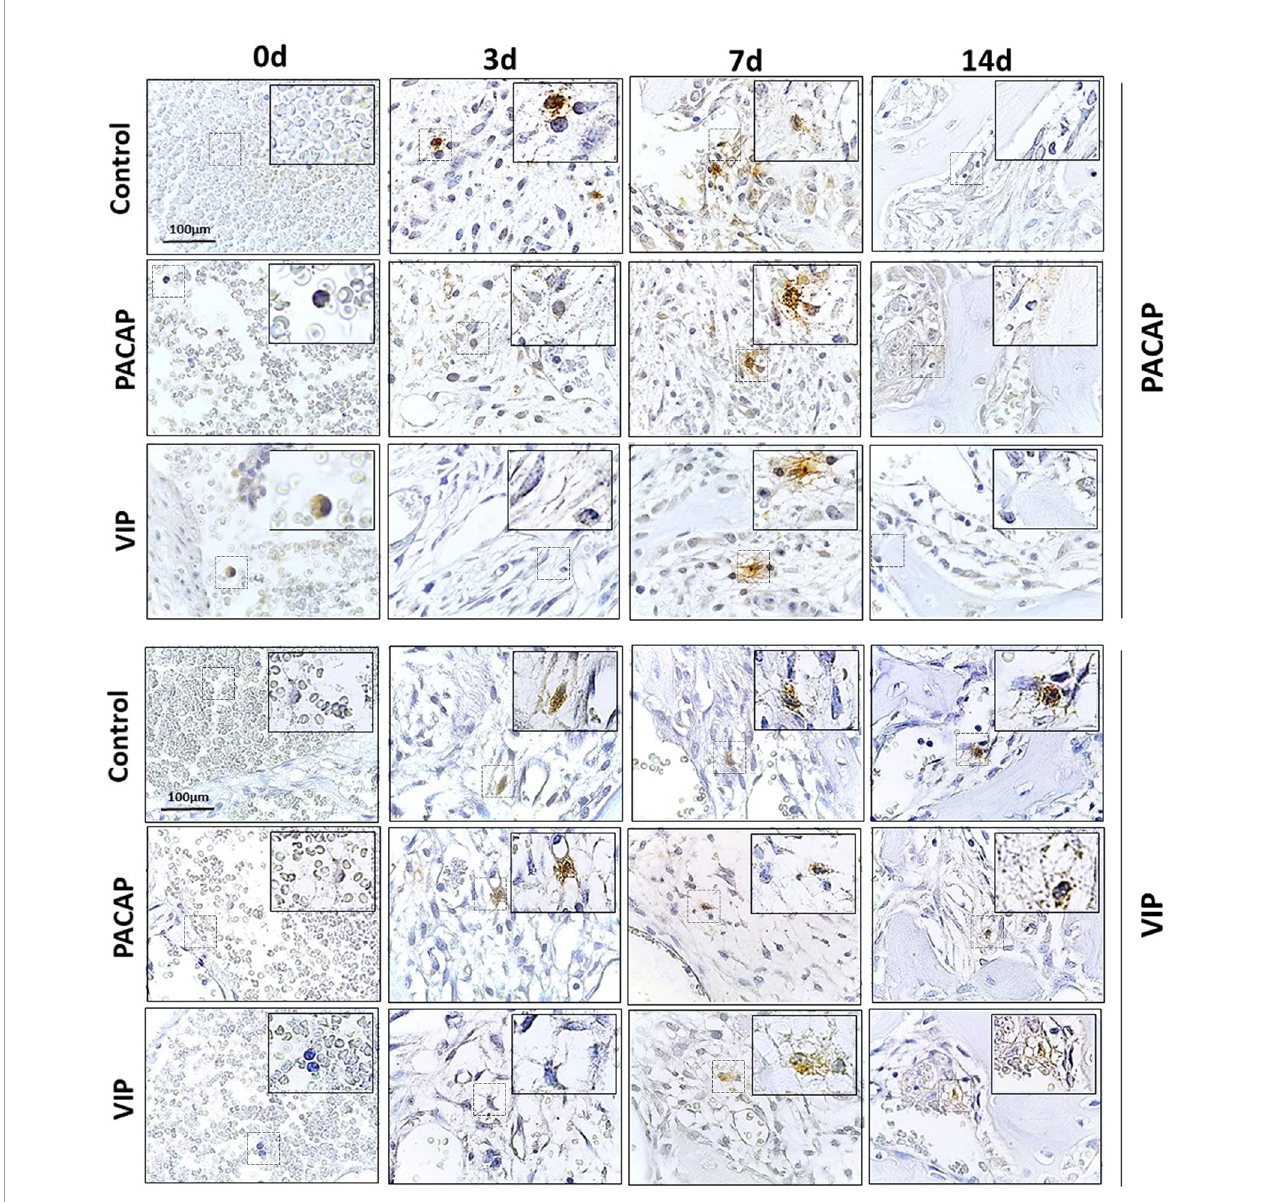
FIGURE 4 | Immunohistochemistry analysis for VIP+ and PACAP+ cells present in the bone healing process in the control, VIP and PACAP treated mice. Representative sections from medial thirds of the socket at days 0h, 3, 7 and 14 days after tooth extraction. Anti-staining Mayer hematoxylin; objective of